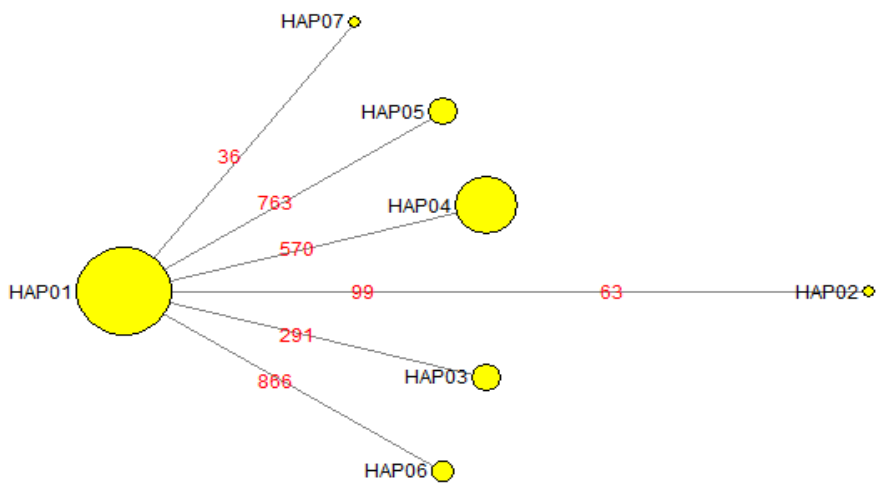
Figure 2. Minimum spanning network showing relationship among seven mtDNA haplotypes based on 909 bp concatenated mtDNA sequences. Each circle denotes inferred haplotypes drawn to proportionate number of individuals. Details of individuals representing each haplotype were given in Table 1. Numbers above branches indicate mutation positions between haplotypes (also see Supplementary Table S5 for information on base positions).